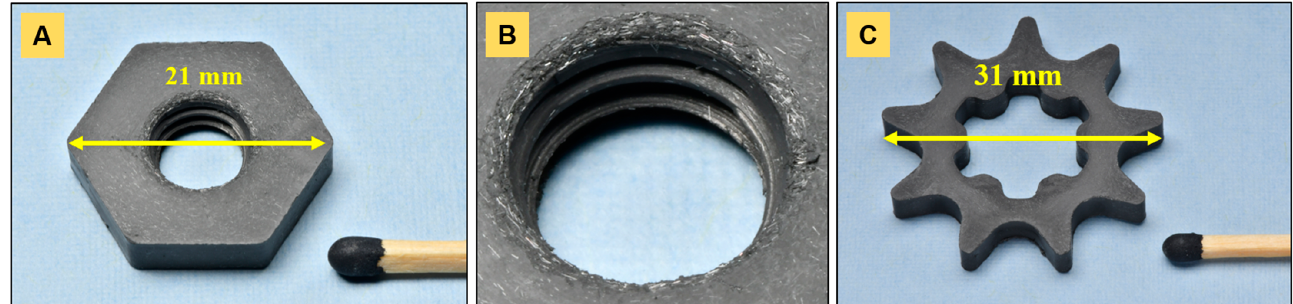
Figure 1. Powder-injection molded components, here containing fibers: ( A ) hexagon nut, ( B ) magnification on the threaded hole, ( C ) 9-tooth sprocket.